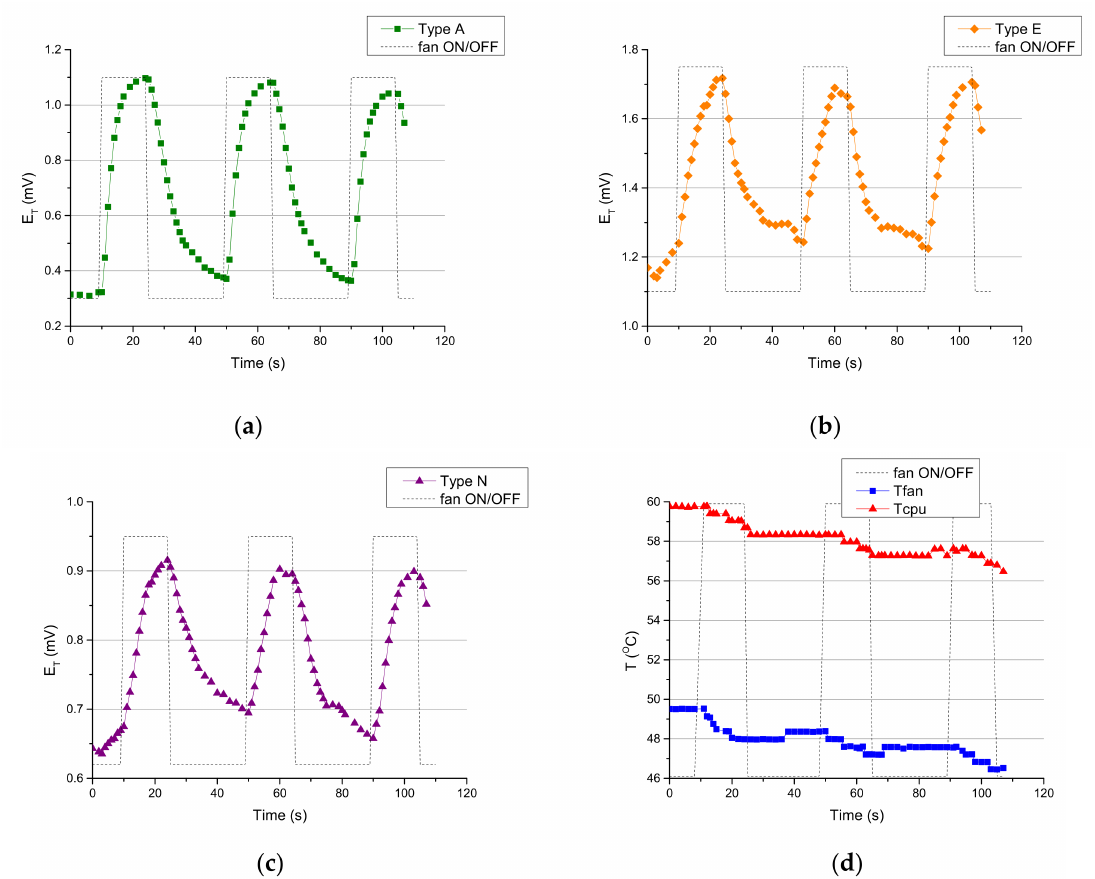
Figure 18. The voltage response of the sensors—measurements every 1 s: ( a ) sensor version A; ( b ) sensor version E; ( c ) sensor version N; ( d ) the temperature of FAN_heat_sink block (blue) and CPU_heat_sink block (red)—pyrometer measurement. The black dotted line indicates the moments when the fan was switched on and